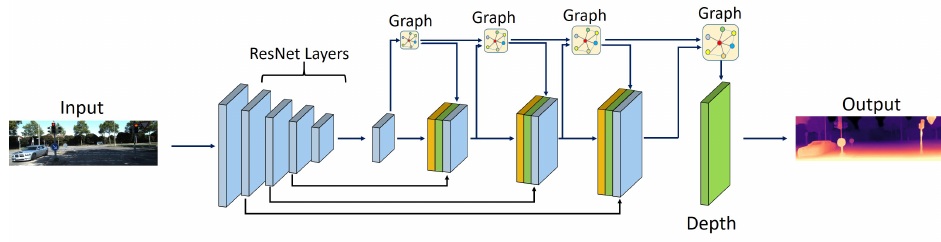
Figure 13. Developed network by Masoumian et al. [34].